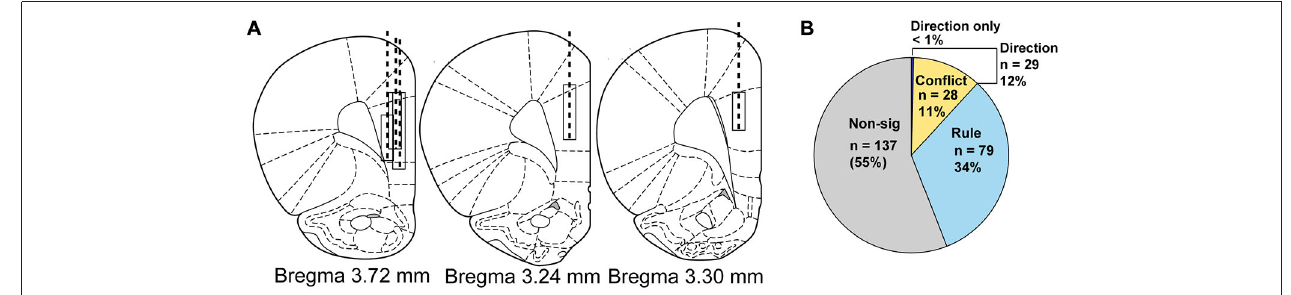
FIGURE 2 | Electrode implant beginning and final positions, drive paths and classification of neural activity by regression. (A) Atlas schematics showing electrode wire bundle implant locations (top of box) and location at completion of study (bottom of box) and general drive path (dashed line) for five rats. (B) Pie chart showing by number and percentage the breakdown of neural activity types from regression analysis on neural firing, with non-modulated neuron data shown in gray, rule neurons in light blue, conflict neurons in yellow and direction neurons in